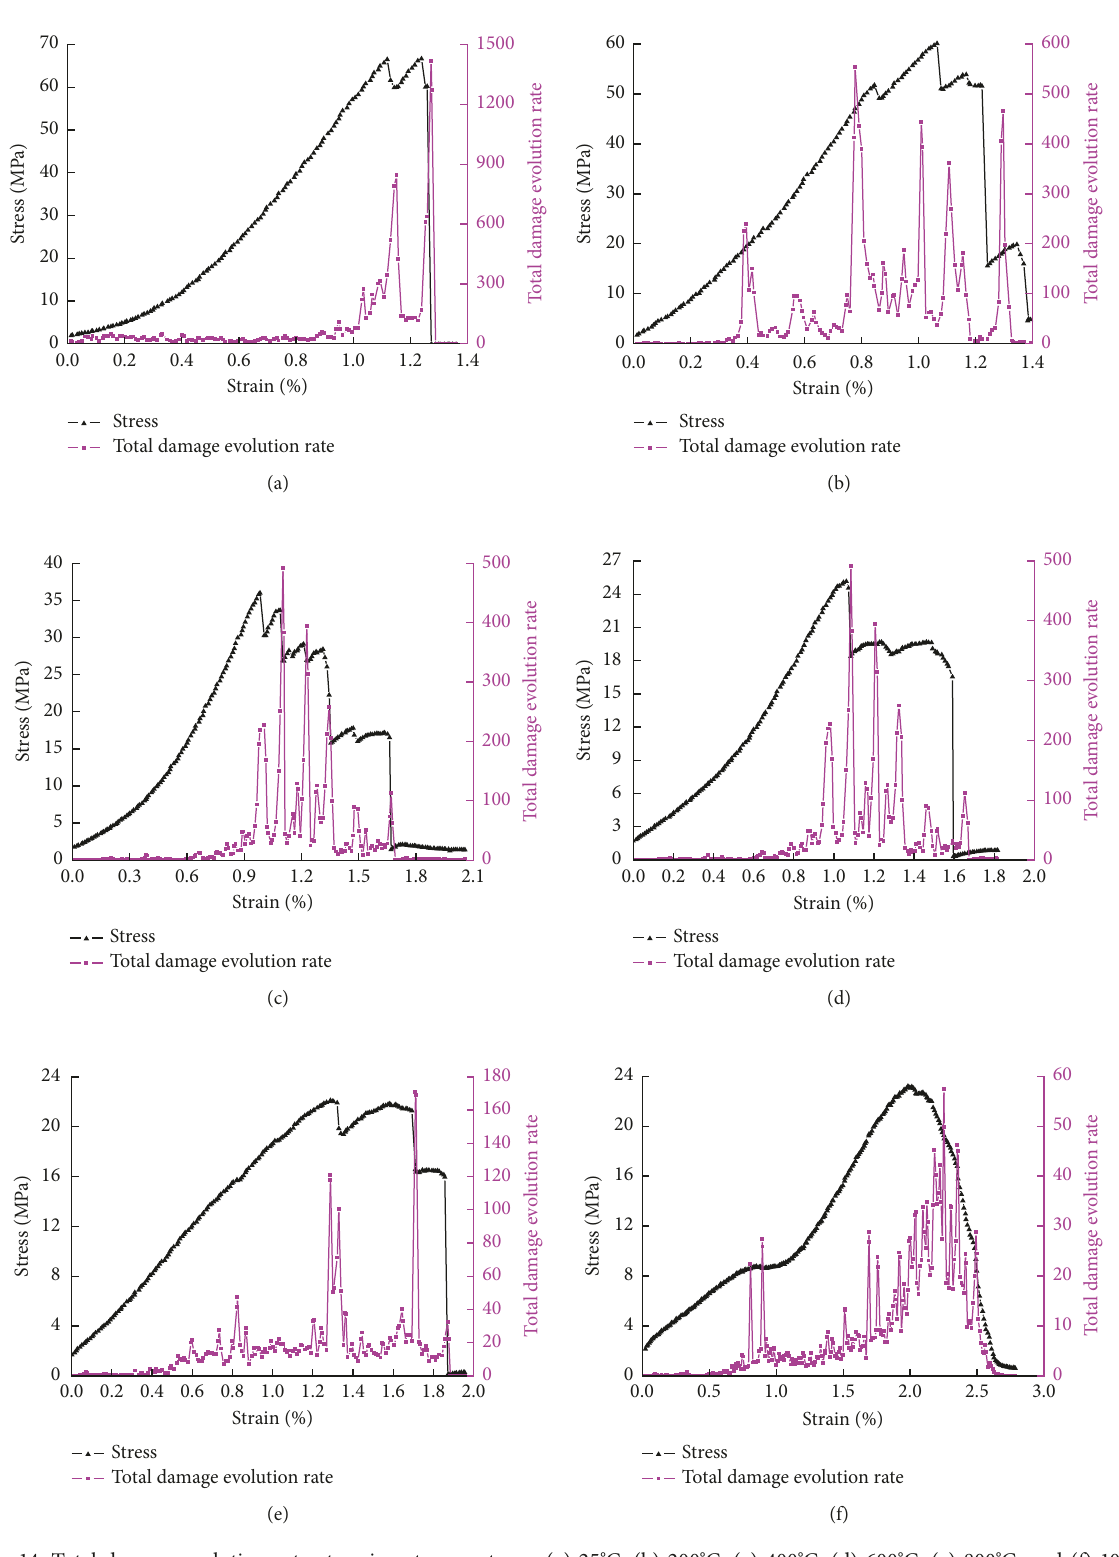
Figure 14: Total damage evolution rate at various temperatures. (a) 25 ° C, (b) 200 ° C, (c) 400 ° C, (d) 600 ° C, (e) 800 ° C, and (f) 1000 °